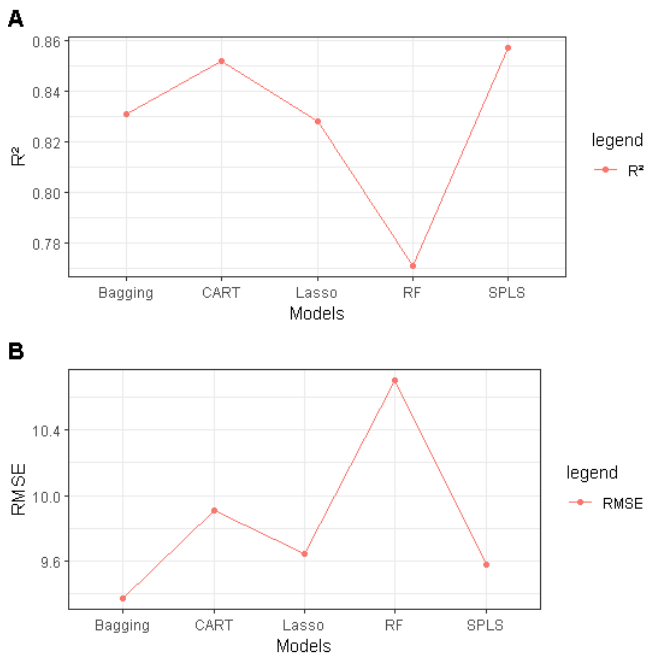
Figure 4. Comparison of models ( A ): R 2 during summer period of 2013 and 2014; ( B ): RMSE